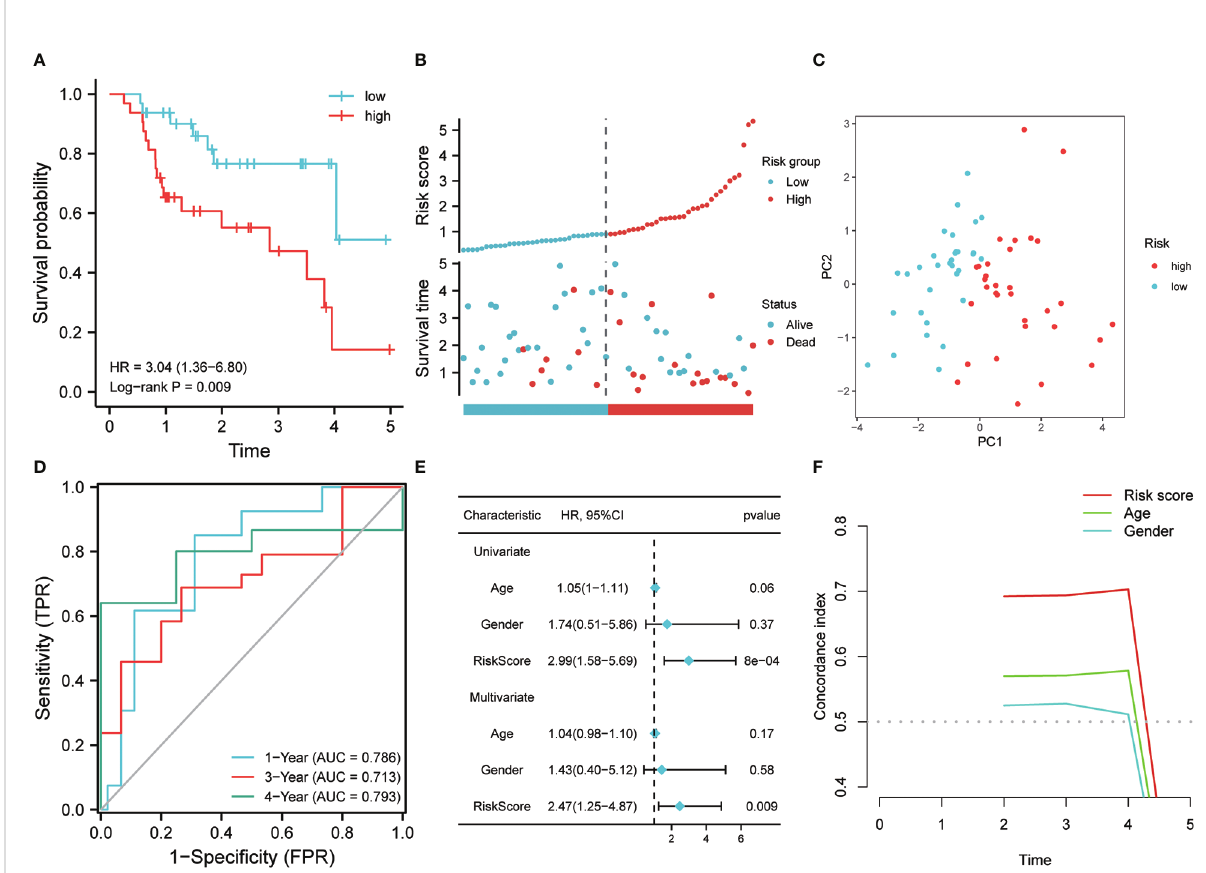
FIGURE 4 The effectiveness of the risk model was veri fi ed in the validation set. (A) K-M method was used to draw the survival curve according to risk score, and for the comparison, the log-rank test was employed. (B) The distribution of risk score and survival status between high and low-risk groups. (C) To evaluate the differentiation between groups with high and low risk, PCA was utilized. (D) Through ROC analysis, the predictive role of the risk model in the validation queue was evaluated. (E) Univariate and multivariate Cox analysis. (F) C-index analysis was used to evaluate the prediction ability of the